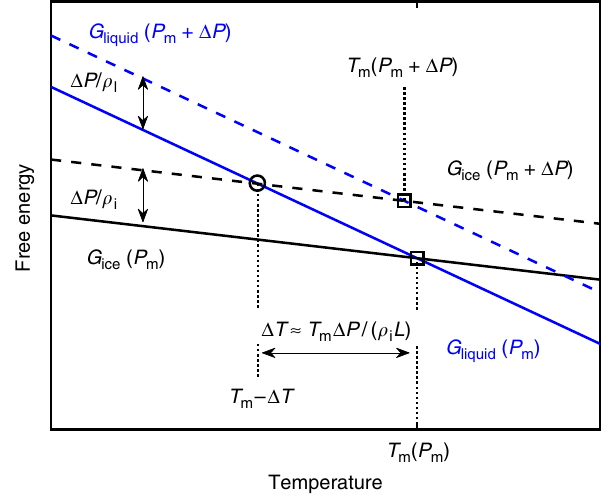
Fig. 2 Equilibrium coexistence of ice and water. Illustration of potential equilibrium states implied by changes in Gibbs-free energy satisfying d G = d P / ρ − s d T , with P pressure, ρ density, s speci fi c entropy, and T temperature. The steeper (blue) lines depict the entropic reduction to the free energy of liquid water at pressure P m (solid) and P m + Δ P (dashed) as temperature increases. The more shallow (black) lines for ice are somewhat less sensitive to temperature because of the lower-speci fi c entropy of the solid state (i.e., s i ≈ s w − L / T m , where L is the latent heat of fusion). Conditions where the free energies are equal (open symbols) represent states of thermodynamic equilibrium. The bulk equilibrium temperature T m at pressure P m is slightly warmer than that at P m + Δ P because the shift in enthalpy with Δ P for each phase is inversely dependent on its density and ρ i < ρ w . The surface energy of highly curved ice – liquid interfaces at the entrance to pore throats (and the intermolecular interactions across premelted fi lms) causes the pressure in ice to be higher than that in the liquid so that equilibrium is achieved at T m − Δ T ≈ T m [1 − Δ P /( ρ L )] (Dash et al. 11 i